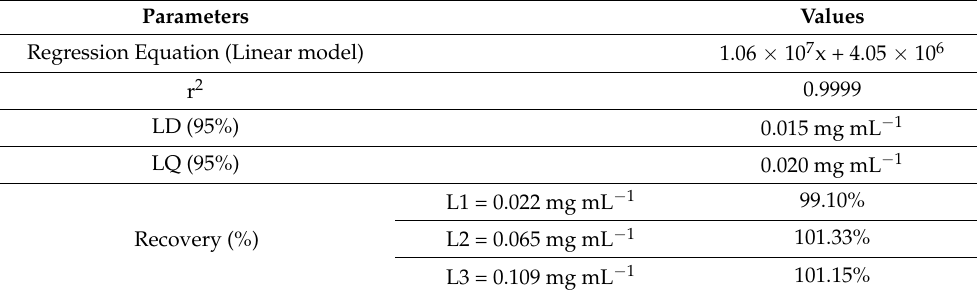
Table 2. Validation parameters for quantification of docosahexaenoic acid in human milk.